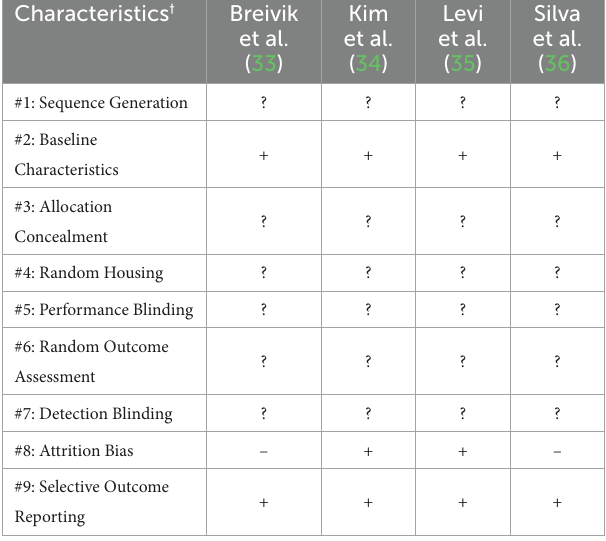
TABLE 2 Risk of bias assessment as adapted from Hooijmans et al. (30). Characteristics